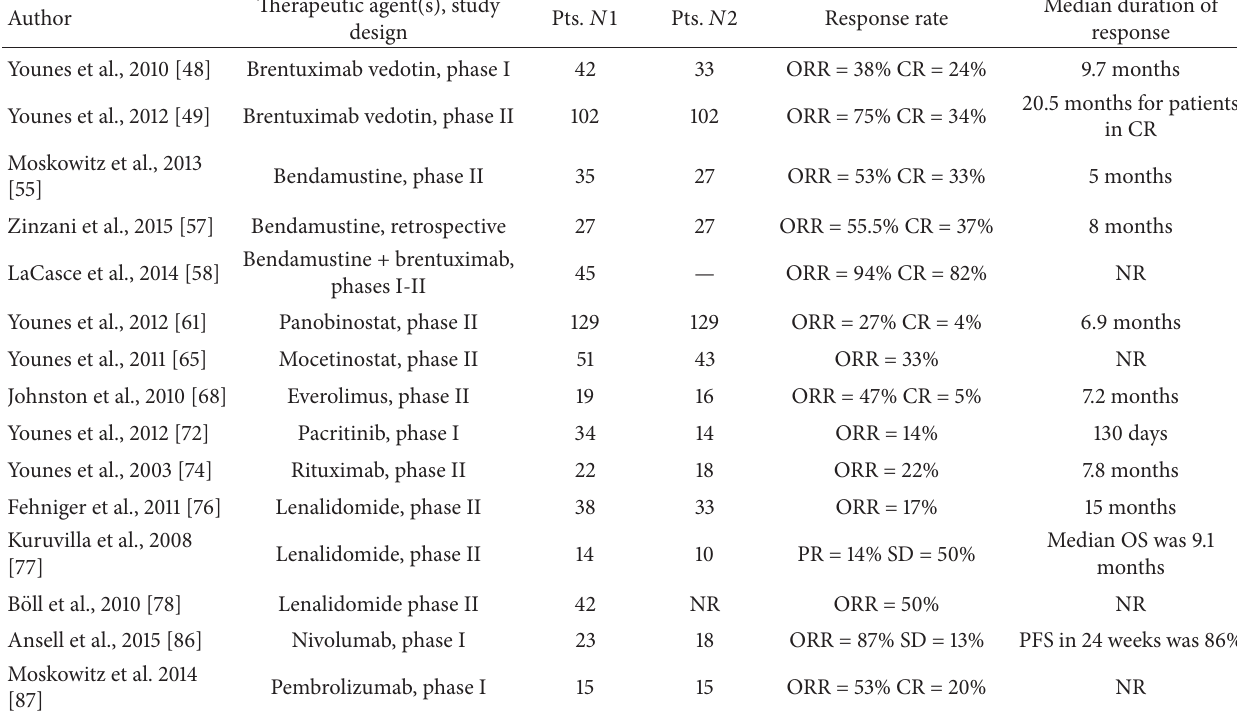
Table 1: Novel agents evaluated in relapsed/refractory HL patients after